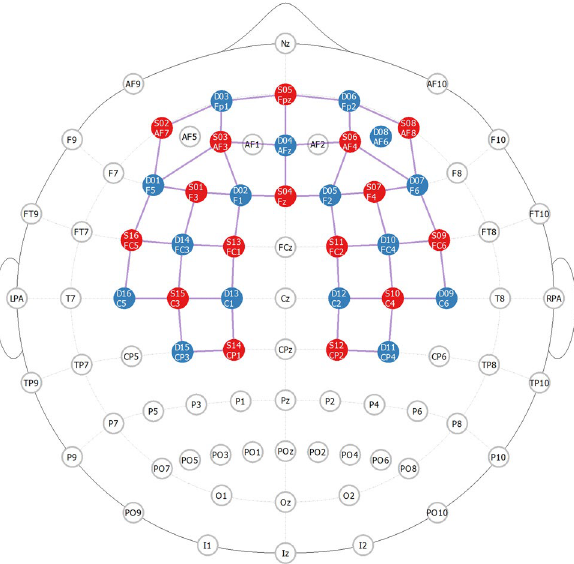
Figure 2. Optode placement during functional Near-Infrared Spectroscopy (fNIRS) assessments. fNIRS probe design was based on optode positioning in the international 10–20 space, and optodes were mounted in a modified electroencephalography cap in the corresponding position. Red dots represent light source, blue dots represent light detector optodes. Probe channels are shown as purple lines. The fNIRS probe and current figure was created with NIRSite 2020.7 (www. nirx.